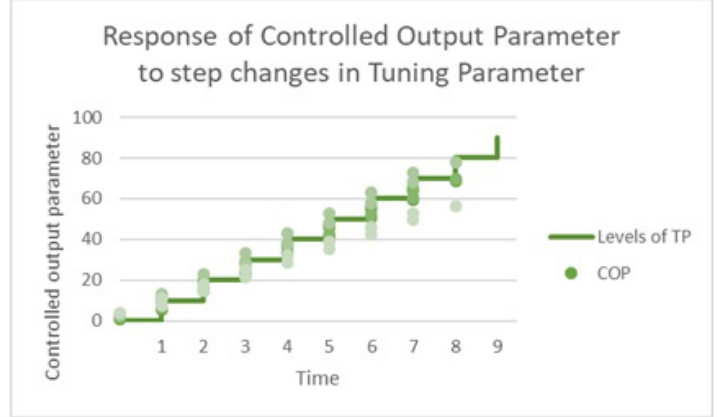
Figure 7. Response of the controlled output parameter to step changes in the tuning